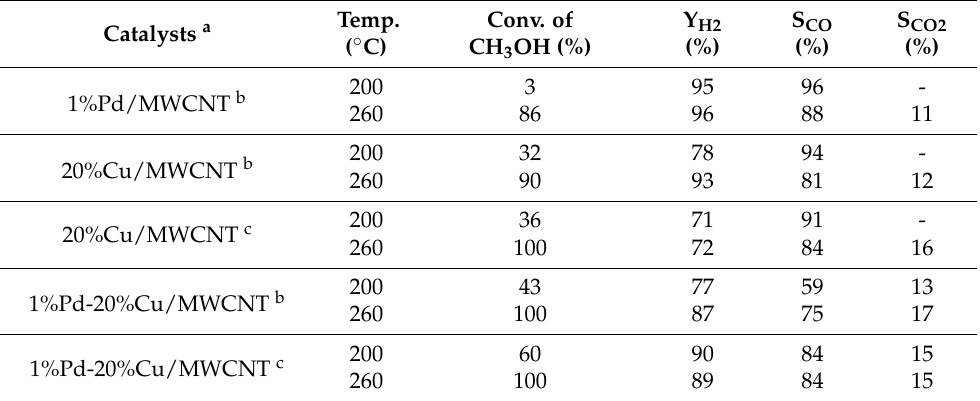
Table 3. The catalytic activity results obtained for the monometallic copper and bimetallic Pd-Cu/MWCNTs catalysts during the decomposition of methanol reaction. Temp. Catalysts a